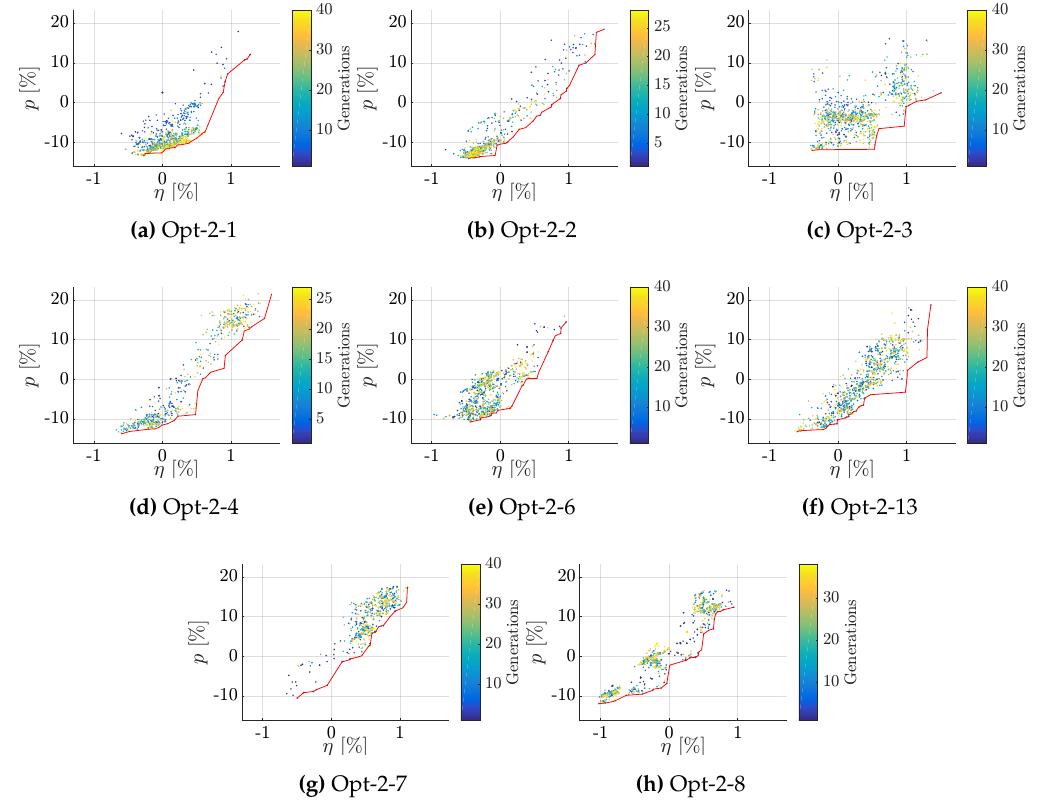
Figure A4. Pareto fronts for Opt-2 for η and pressure pulse objectives (Group 1: ( a – d ); Group 2: ( f – h